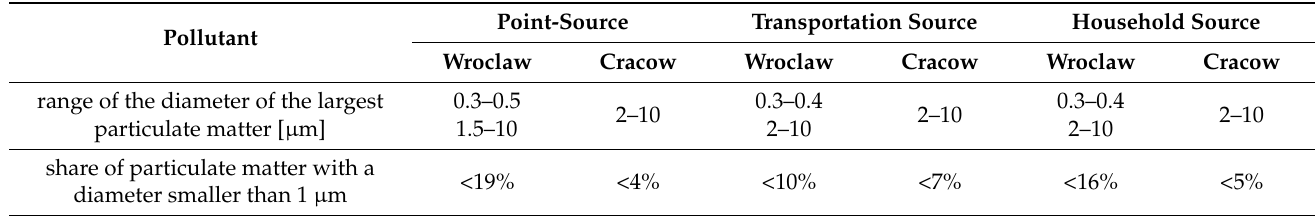
Table 2. Detailed results of PM distribution in Wroclaw and Cracow.